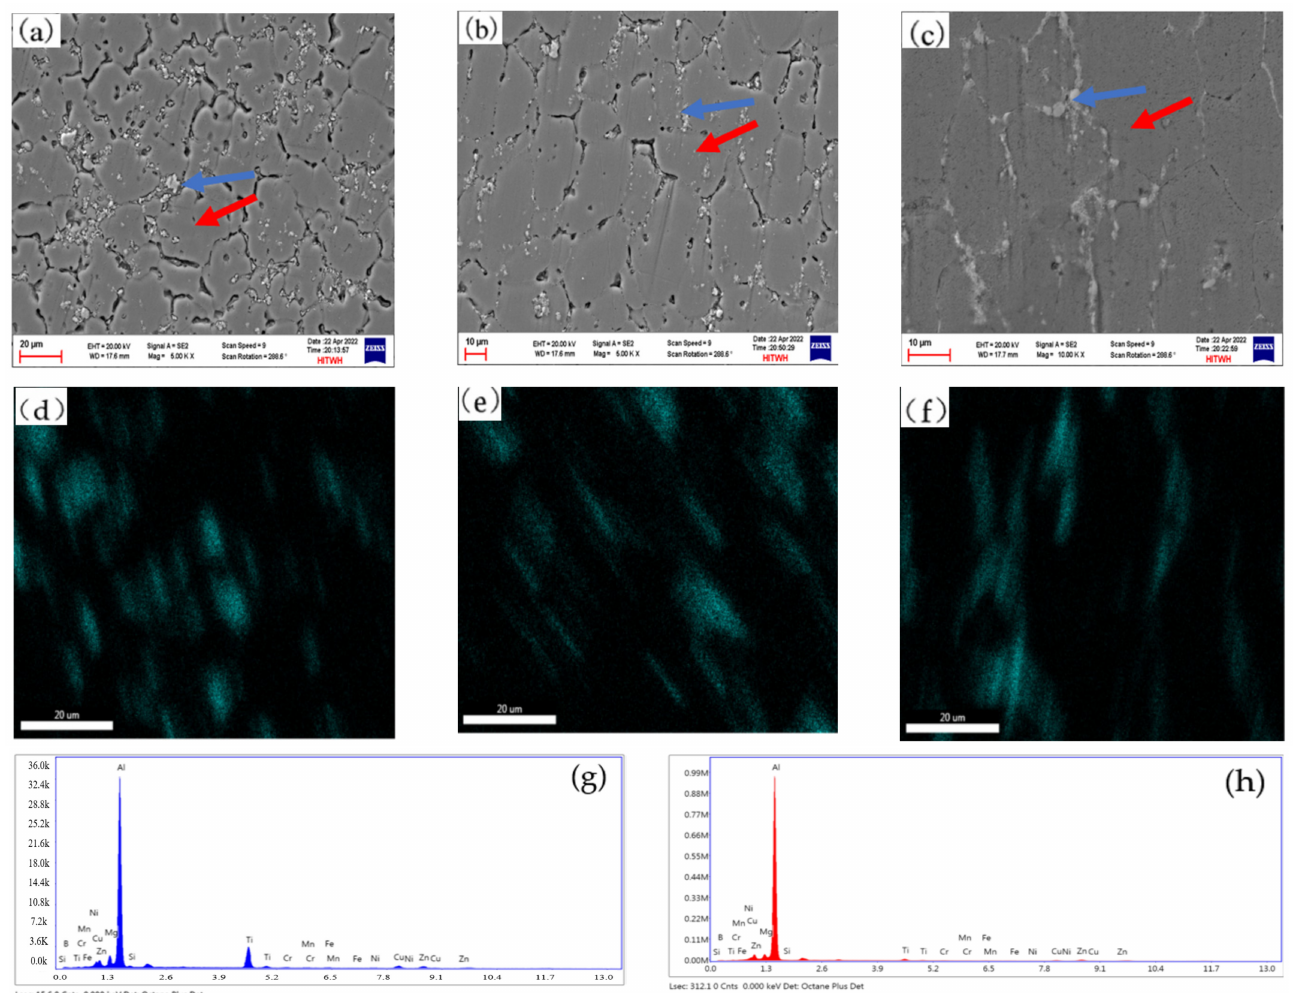
Figure 8. Microstructure in different regions of TiB2 nanoparticle-reinforced 7075 aluminum alloy welding wire TIG arc additive manufacturing specimen. ( a ) Microstructure at the top, ( b ) microstruc- ture in the middle and ( c ) microstructure at the bottom of the manufactured sample. ( d ) Ti element distribution at the top, ( e ) Ti element distribution in the middle and ( f ) Ti element distribution at the bottom. ( g ) EDS spectrum of the area indicated by the blue arrow and ( h ) EDS spectrum of the area indicated by the red